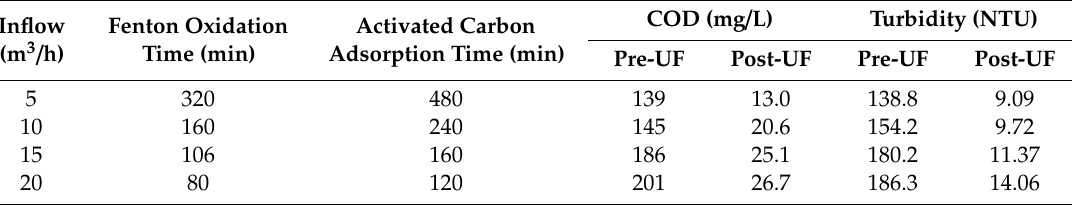
Table 3. Analytical data of combined